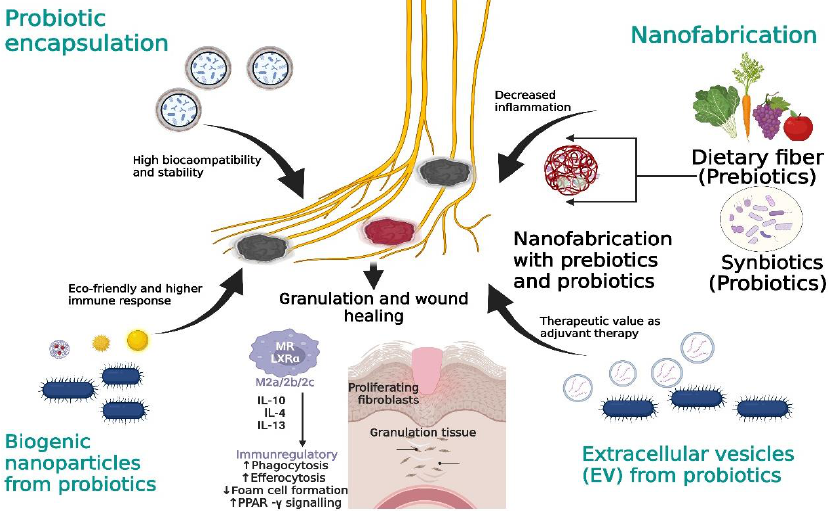
Figure 4. Novel approaches to target DFU prognosis. Probiotic encapsulation ensures the probiotics’ long-term stability against chronic DFUs. Dietary fiber will be used in nanofabrication with prebiotics and probiotics for efficient probiotic regulation. Biogenic NPs boost immune activation; probiotic-derived EVs can be used as an alternative therapeutic delivery agent.